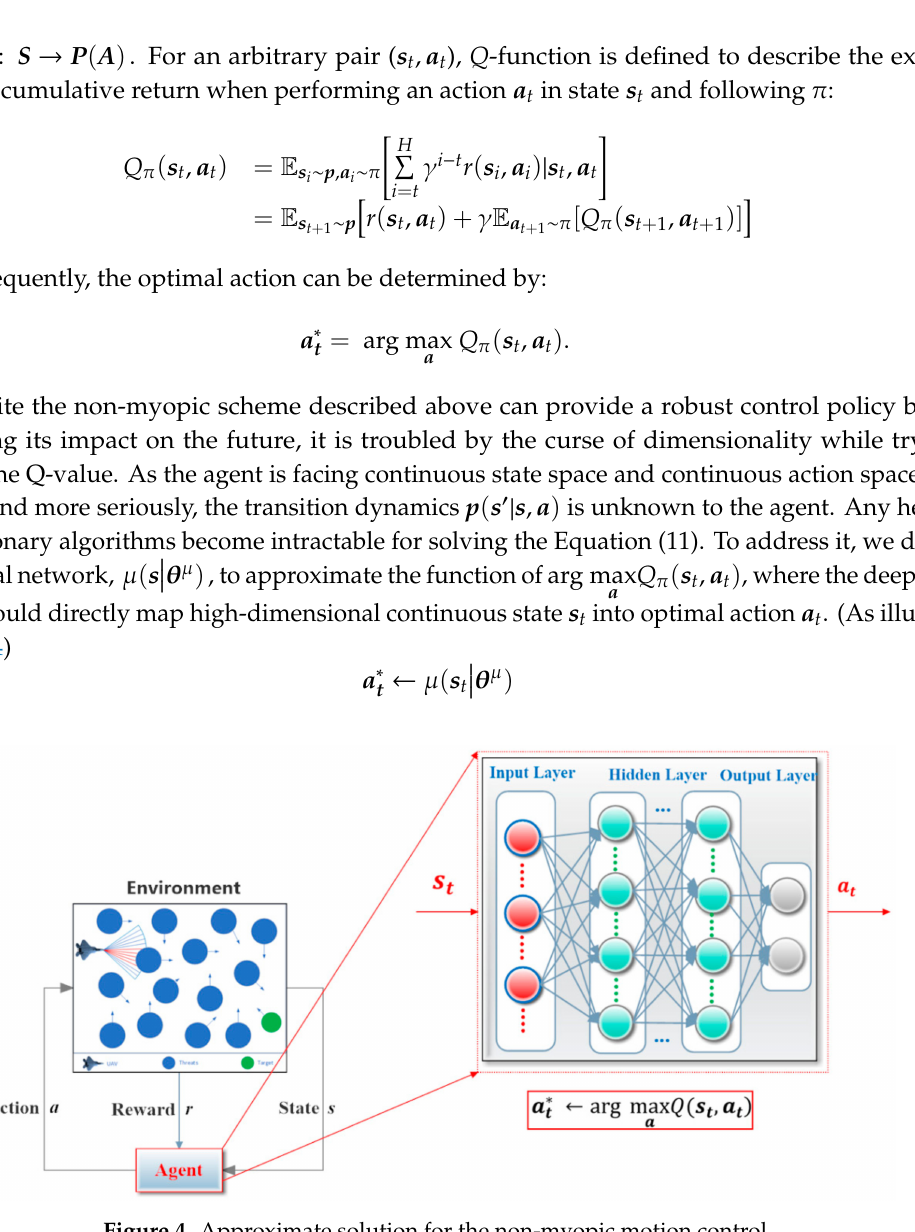
Figure 4. Approximate solution for the non-myopic motion